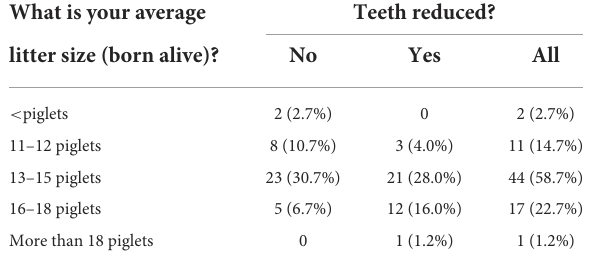
the third most selected option, after “teeth not being reduced” and “poor milk production”, as 46.7 and 38.7% selected this option for piglet facial and sow teat lesions, respectively (Supplementary material III, Table 2). For those who did not practice teeth reduction, “large litters” was the top reported reasons for piglet facial and sow teat lesions (Supplementary material III, Figure 1). In contrast, too large litter size was selected as the least frequent reason to carry out teeth reduction (Table